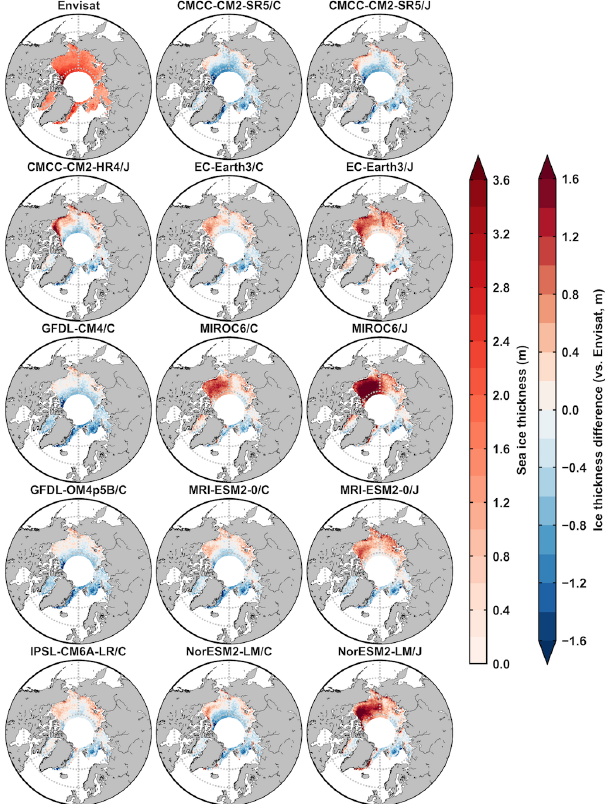
Figure A5. The 2003–2007 February mean Arctic ice thickness from Envisat data (first picture, m) and ice thickness differences between model outputs and Envisat data (m). The second and third columns are from the five OMIP1 and OMIP2 model out- puts of CMCC-CM2-SR5, EC-Earth3, MIROC6, MRI-ESM2-0, and NorESM2-LM, respectively.